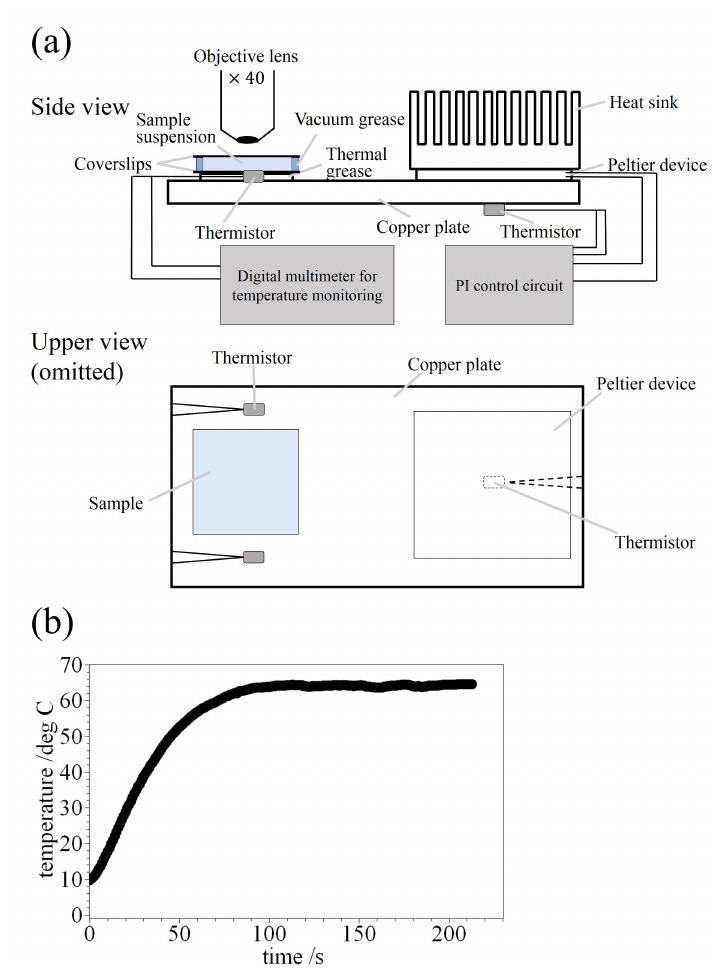
Figure 1. ( a ) Schematic illustration of temperature-control system. We used three thermistors; the two were for temperature monitoring, and the other was for feedback in order to control the plate temperature. The temperature of the copper plate was controlled through a proportional integral (PI) circuit and a Peltier device (deviation < 0.1 ◦ C). The measured temperature was defined as an averaged value using two thermistors. Thickness of the sample suspension is within 1 mm; ( b ) The thermal profile was measured by thermistors in the case of the situation from 10 ◦ C to 65 ◦ C. The temperature reached above ca. 42 ◦ C within 50 s from the beginning of